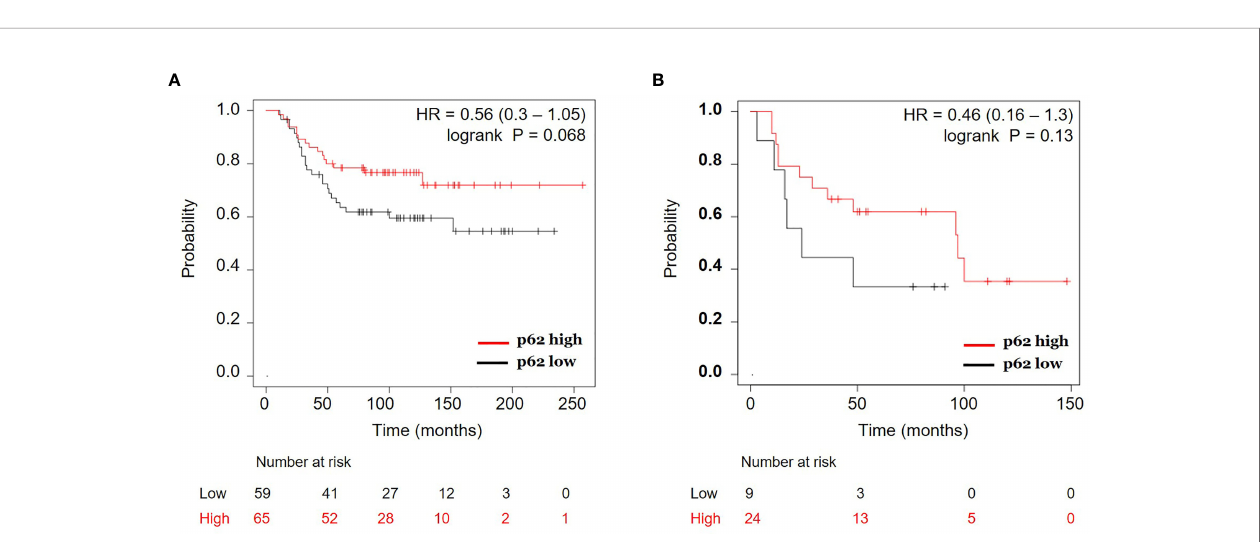
FIGURE 7 | Correlation of p62 protein expression and overall survival in estrogen receptor (ER) negative breast cancer. Kaplan-Meier curves of ER-negative breast cancer patients with p62 protein high vs. p62 protein low for overall survival were generated using the webtool Kaplan-Meier Plotter (http://kmplot.com) (24) using two breast cancer datasets: (A) Liu et al. (2014) (27) and (B) Tang et al. (2018) (28). HR, hazard ratio.